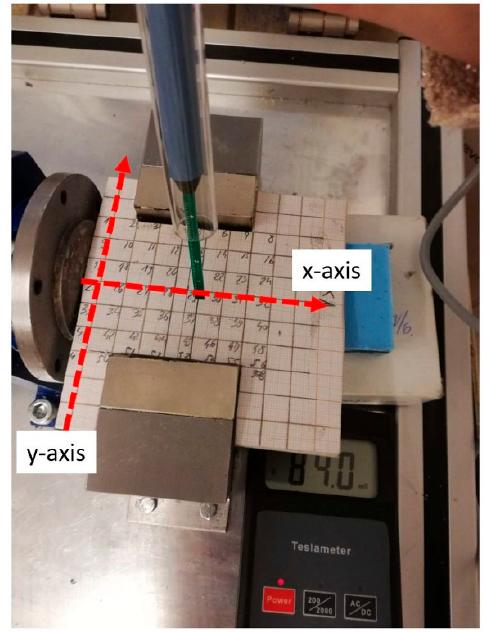
Figure 4. Location of measuring points for the magnetic field.